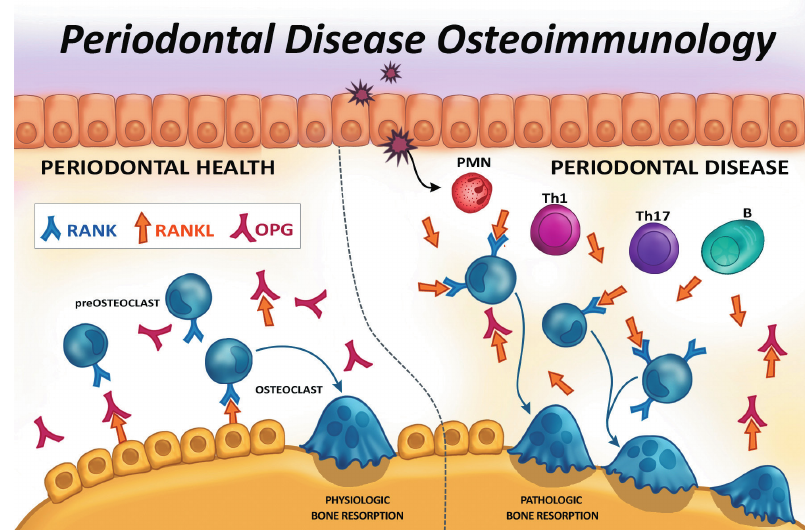
Figure 4- Periodontal disease